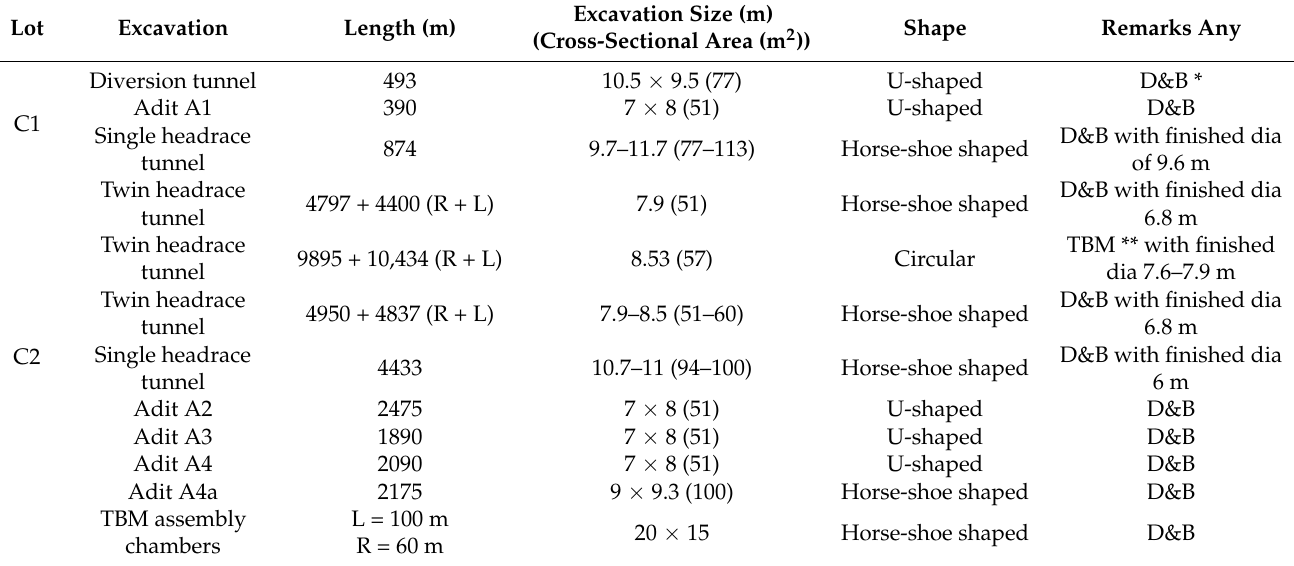
Table 1. Underground excavation details of three lots in the